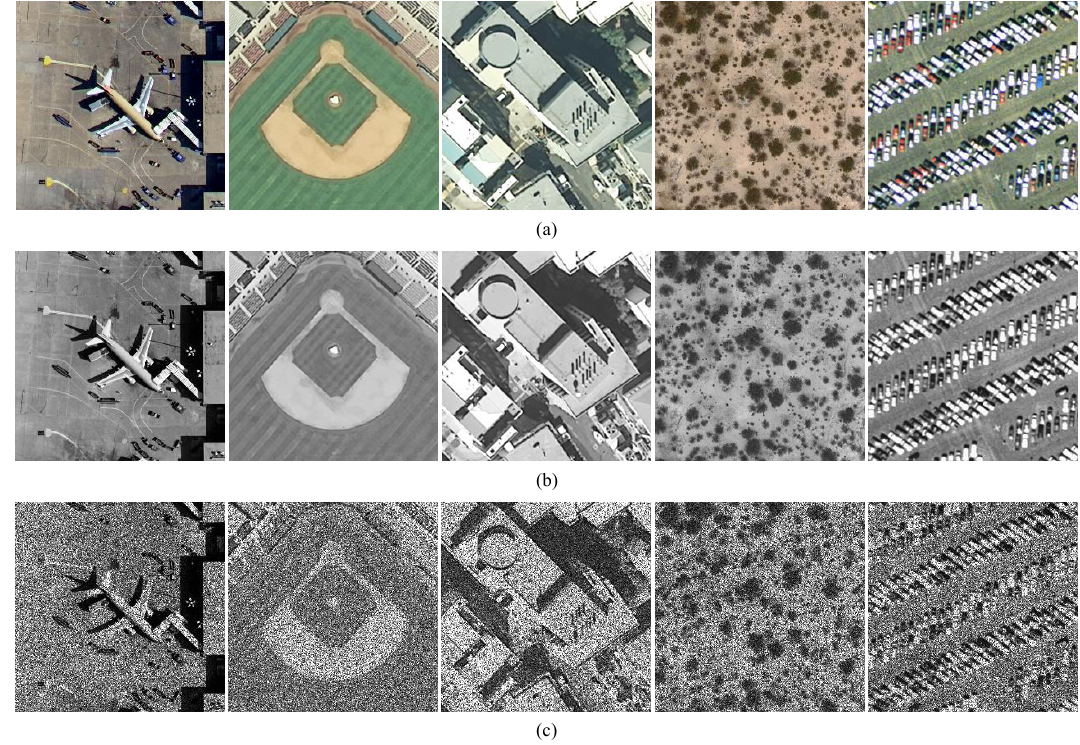
Figure 6. Examples of simulated SAR images. ( a ) RGB images. ( b ) Grayscale images. ( c ) Simulated SAR